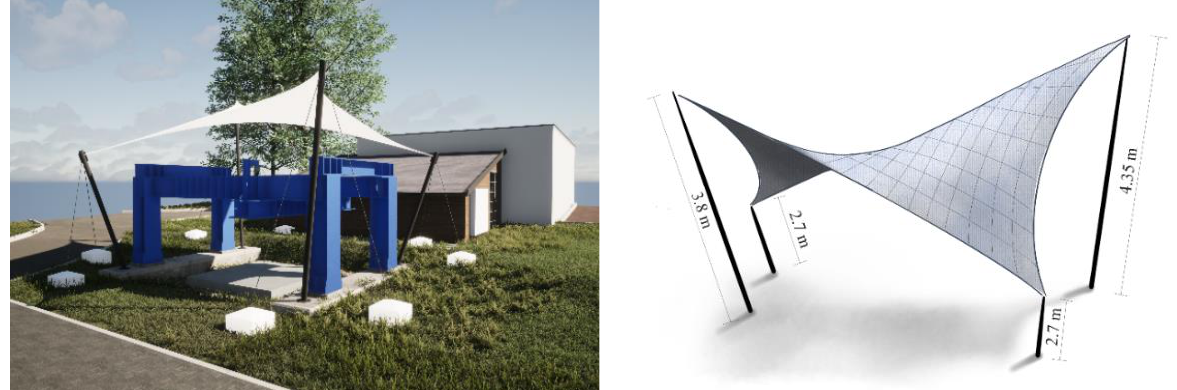
Figure 2. Visualization of the designed tensile structure ( left ), vertical dimensions of the tensile structure ( right ).